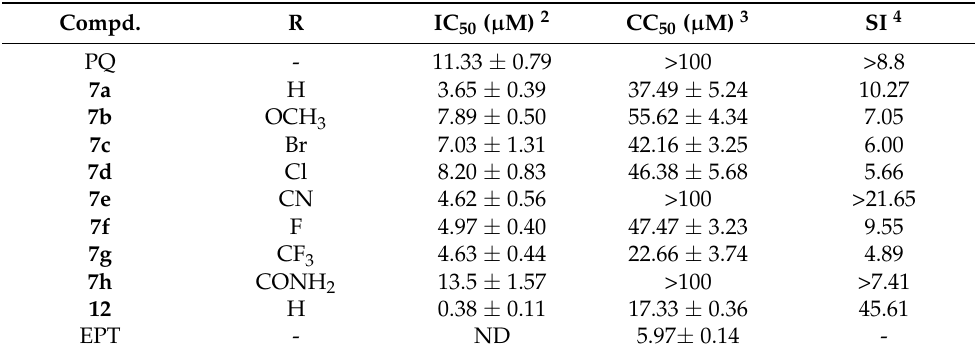
Table 1. Blood schizontocidal activity and cytotoxicity of 5-phenoxy primaquine analogs ( 7a – 7h ) and the tetraoxane hybrid ( 12 ) 1